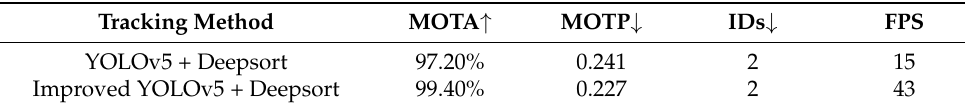
Figure 13. Algorithm tracking effect of UAVs in small target and scale change. ( a ) YOLOv5 + Deepsort; ( b ) improved YOLOv5 + Deepsort. Table 3. Target tracking effect index comparison of multiple UAVs.